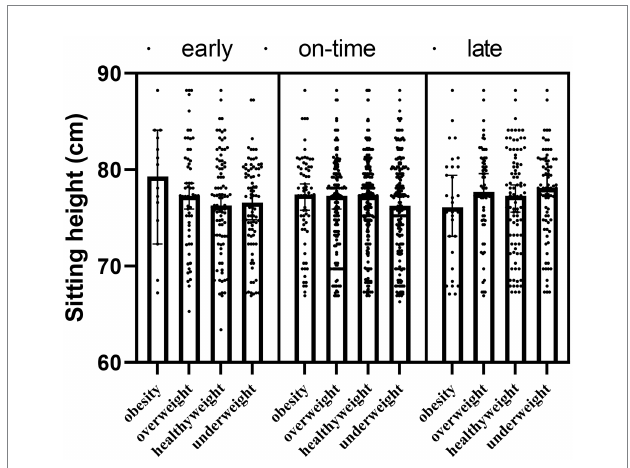
FIGURE 4 The sitting height of participants according to maturity and obesity